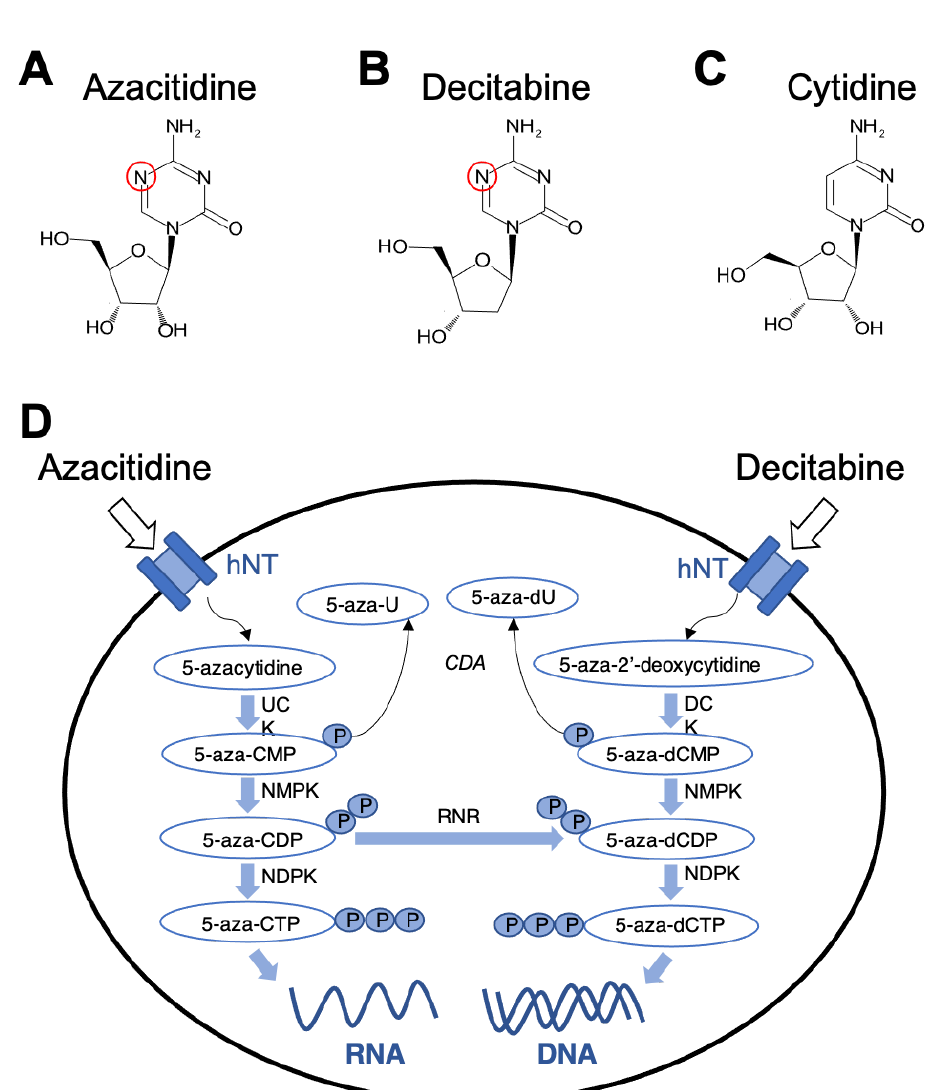
Figure 1. Incorporating mechanisms of azacytidine and decitabine into RNA and DNA. Chemical structures of ( A ) azacytidine, and ( B) decitabine, which are analogs of ( C ) cytidine. ( D ) Both azacitidine and Decitabine have similar mechanisms of integration into RNA and DNA, respectively. These nucleoside analogs are transported into the cell via human nucleoside transport (hNT) channel. Azacitidine (5-azacytidine) becomes phosphorylated via the uridine cytidine kinase (UCK) to form 5-aza-CMP analog, which becomes successively phosphorylated via nucleoside monophosphate kinases (NMPK) and nucleoside diphosphatase kinase (NDPK) to create 5-aza-CDP and 5-aza-CTP, respectively. Decitabine (5-aza-2′-deoxycytodine) becomes phosphorylated by deoxycytidine kinase (DCK) to make 5-aza-dCMP analog, which becomes successively phosphorylated via NMPK and NDPK to form 5-aza-dCDP and 5-aza-dCTP, respectively. Once these ribonucleoside and deoxyribonucleoside analogs are in their active states (5-aza-CTP, 5-aza-dCTP), they can replace cytosines in RNA and DNA, respectively. Note that the monophosphate analogs, 5-aza-CMP and 5-aza-dCMP, can be deaminated into 5-aza-U and 5-aza-dU uridine analogs respectively, by cytidine deaminase (CDA), which helps maintain the surplus of pyrimidines. Additionally, the diphosphate analog 5-aza-CDP, can be converted into 5-aza-dCDP via ribonucleotide reductase (RNR) by reducing the ribonucleoside into a